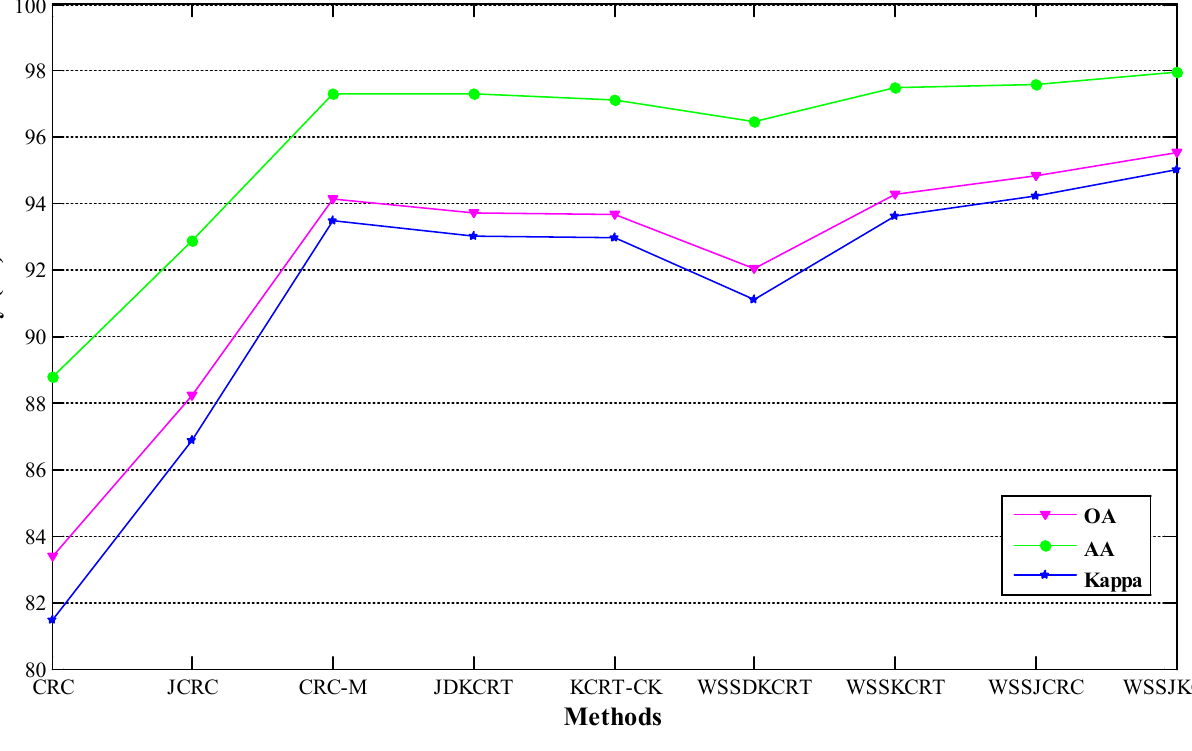
Figure 14. The OA, AA, and Kappa values for different methods on the Salinas scene .